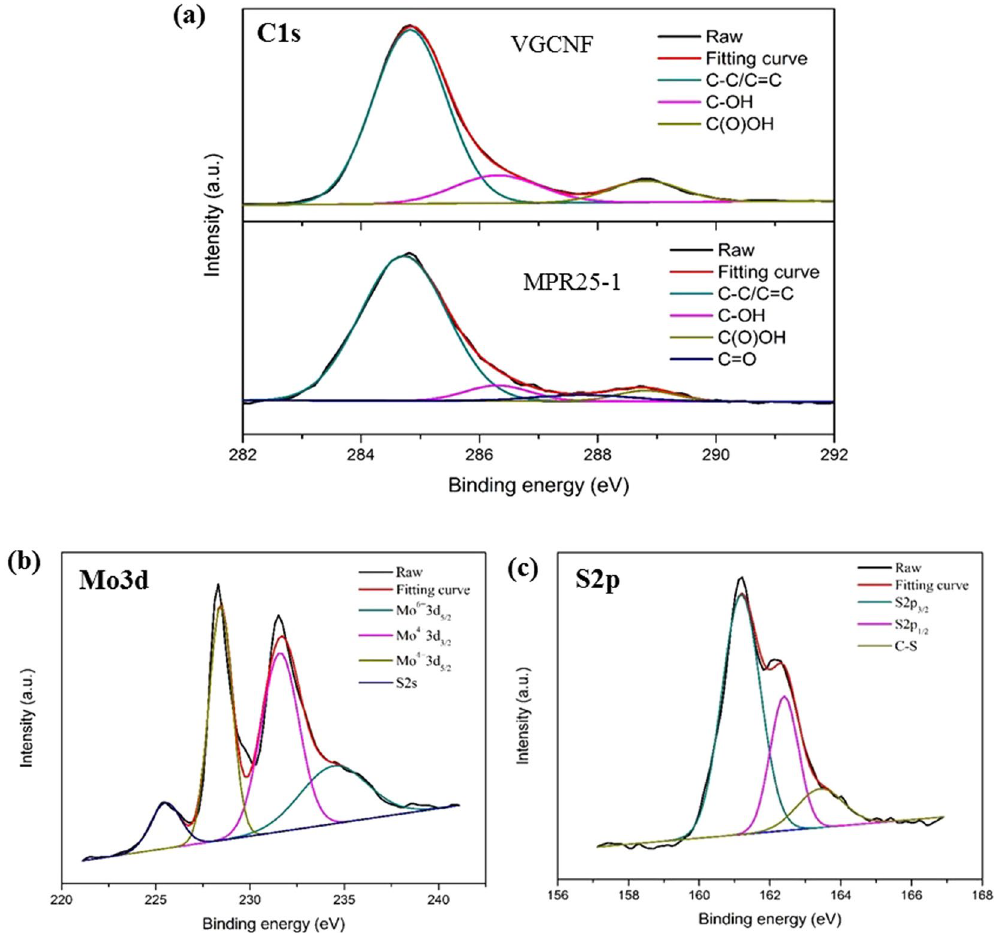
Figure 5. XPS spectra of ( a ) C1s for VGCNF and MPR25-1, ( b ) Mo3d for MPR25-1, and ( c ) S2p for